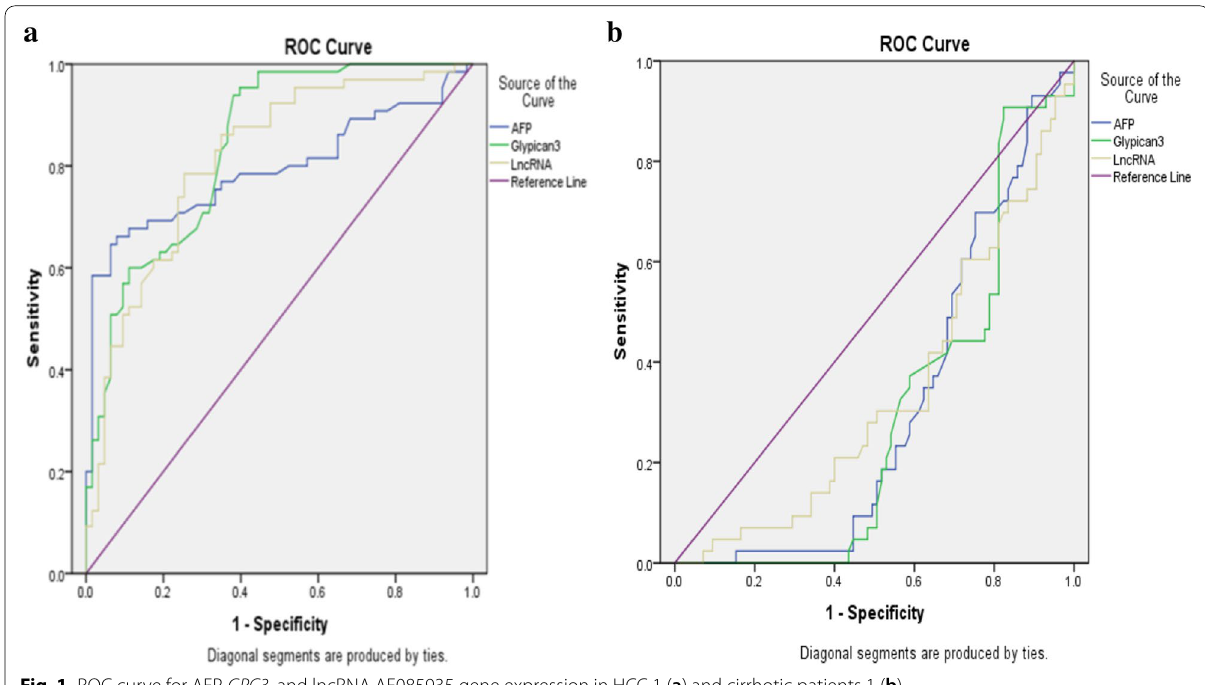
Fig. 1 ROC curve for AFP, GPC3 , and lncRNA AF085935 gene expression in HCC 1 ( a ) and cirrhotic patients 1 ( b )